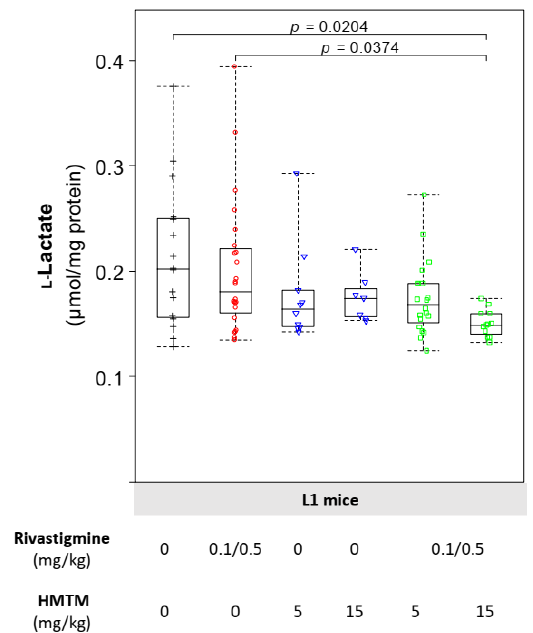
Figure 4. Levels of L ‐ lactate in the brain tissue of L1 mice. For mice under the add ‐ on regimen at the higher concentration of HMTM (15 mg/kg), the levels of L ‐ lactate in the brain of L1 mice were sig ‐ nificantly decreased. Data are expressed as median values ± IQR ( n = 7–24). Differences are consid ‐ ered statistically significant when p < 0.05. Regardless of the doses, the black symbols represent the vehicle group; the red symbols represent the rivastigmine ‐ dosed mice; the blue symbols represent the experimental groups dosed with HMTM; and the green symbols represent the groups dosed with both HMTM and rivastigmine.3.5. HMTM Monotherapy Increases the Levels of Astrocytic LDH ‐ A Subunits. The effects of HMTM on the L ‐ lactate levels and metabolism in the brains of the tau ‐ transgenic mice appeared to be associated with a change in composition of the LDH sub ‐ units favouring an increase in LDH ‐ A, that is, at least partially prevented in the context of the rivastigmine co ‐ administration. Thus, the effect of HMTM on brain metabolism may have a dual cell ‐ specific role favouring the astrocyte conversion of pyruvate into L ‐ lactate by increasing LDH ‐ A subunits, provisioning an unaffected neuronal LDH ‐ B with py ‐ ruvate precursor and ultimately fuelling an MT ‐ facilitated electron transport through the ETC and, in turn, oxidative phosphorylation. When preceded by the chronic administra ‐ tion of rivastigmine, such an HMTM ‐ facilitated metabolic conversion of substrates into bioenergy by mitochondrial oxidative phosphorylation is decreased at the level of the as ‐ trocytic production of L ‐ lactate by LDH ‐ A and mitochondrial function.